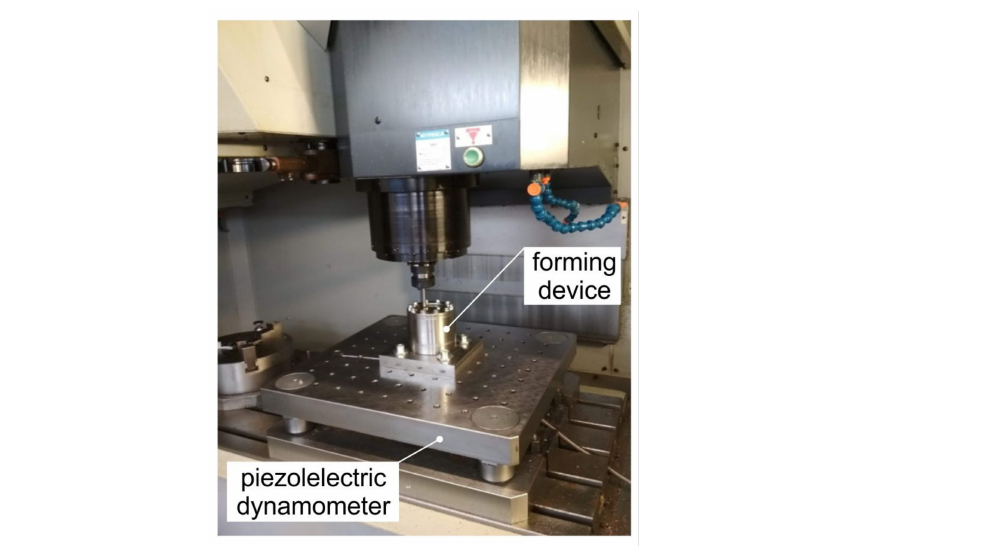
Figure 1. Test stand in the Makino PS95 vertical CNC milling machine.